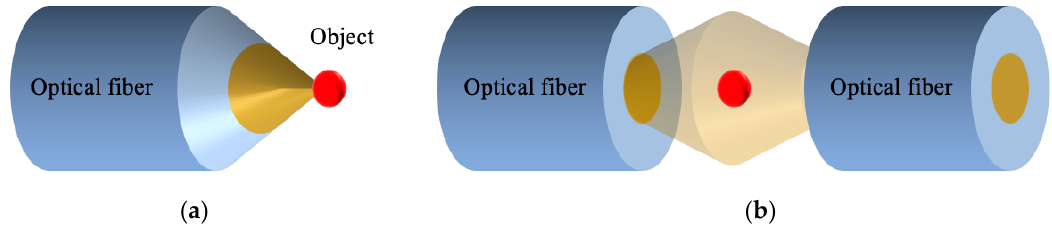
Figure 2. The schematic principle for stable single optical trap generation by ( a ) a fiber taper and ( b ) a dual-beam fiber trap.